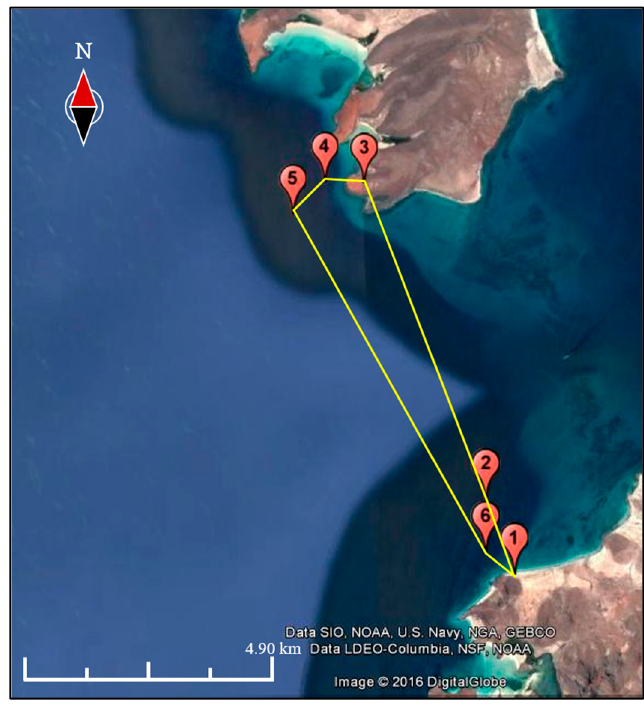
Figure 15. UAV flight path for the trials at El Tecolote beach. The furthest waypoint was set at 8.62 km away from the launch area and the UAV flew at a maximum height of 30 m.